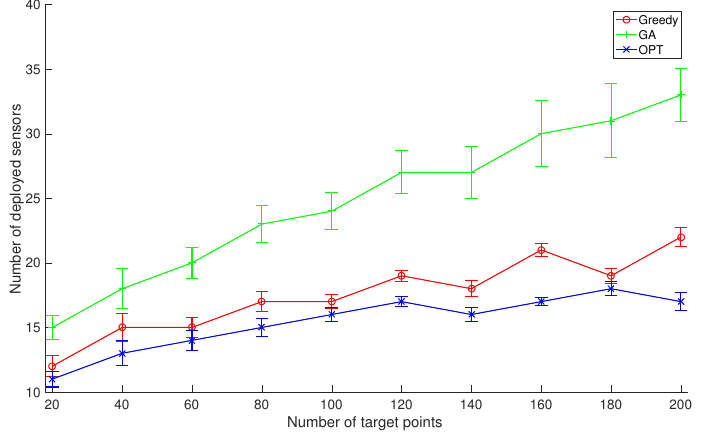
Figure 5. Comparison of the average performance with the standard deviation between GreedyDLDT (Greedy), Genetic Algorithm (GA), and Optimal Algorithm (OPT) for DLDT in response to a varying number of target points.